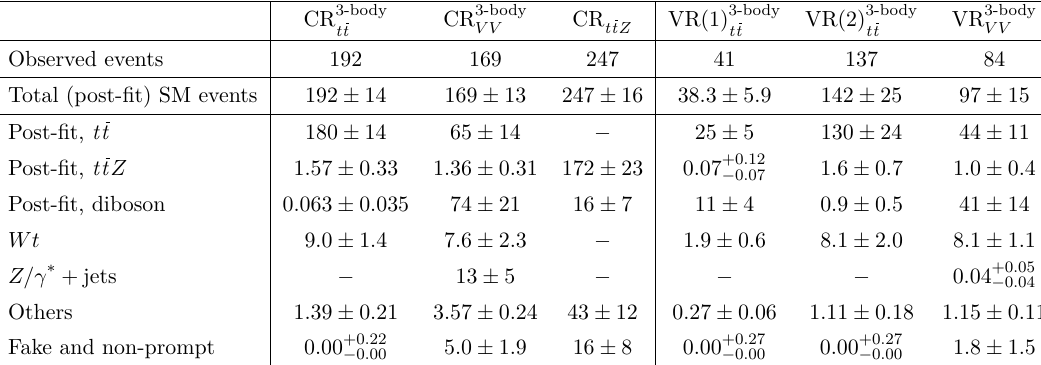
Table 9 . Three-body selection. Background fit results for CR 3-body